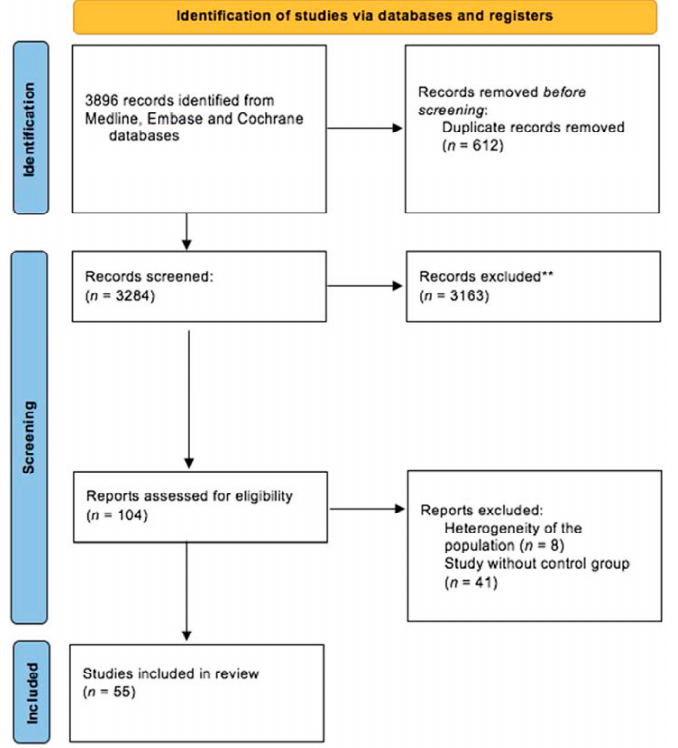
Figure 1. PRISMA Flow chart. ** main reasons for exclusion: studies conducted with children or adolescents, studies including a majority of participants with moderate to severe mTBI, and systematic reviews (screened for research of original articles).